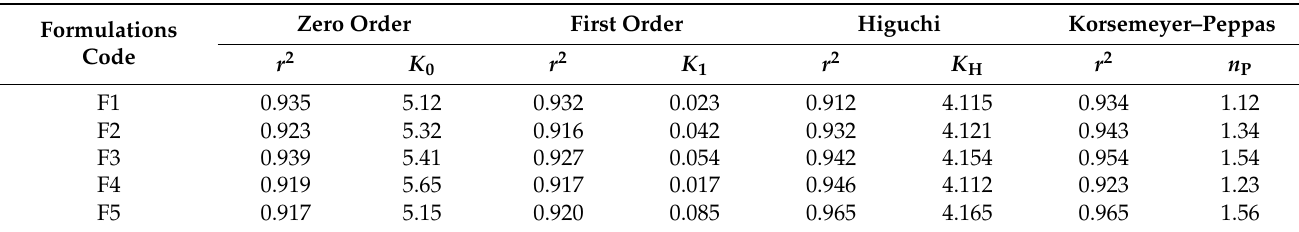
Table 4. Kinetic profiling of esomeprazole-loaded hydrogel formulations.